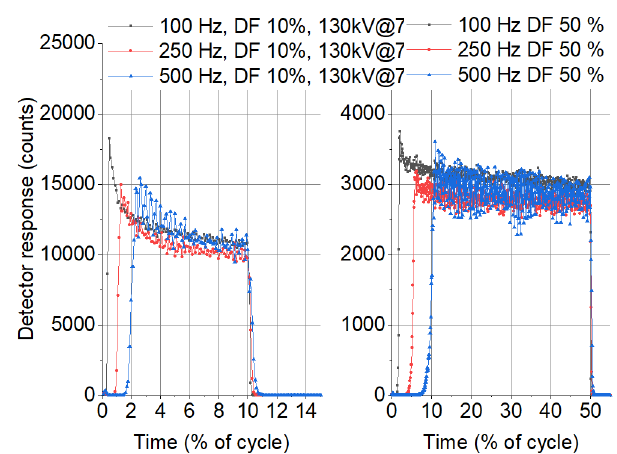
Fig. 13 Cadmium-covered detector response to P-385 D-D neutron generator operated in pulsed mode. Comparison of neutron emission pulse shapes for three frequencies and two values of duty factor at 130 kV @